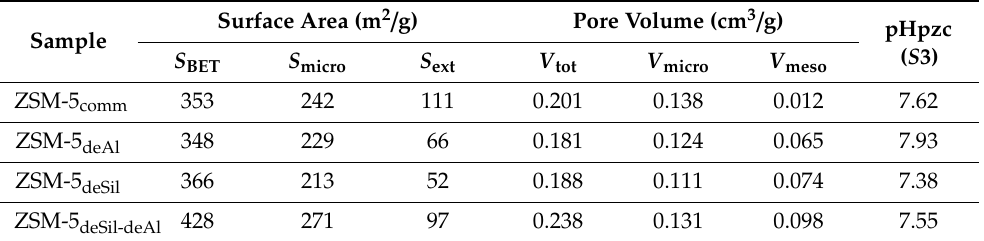
Table 1. Surface area and pore volume of the